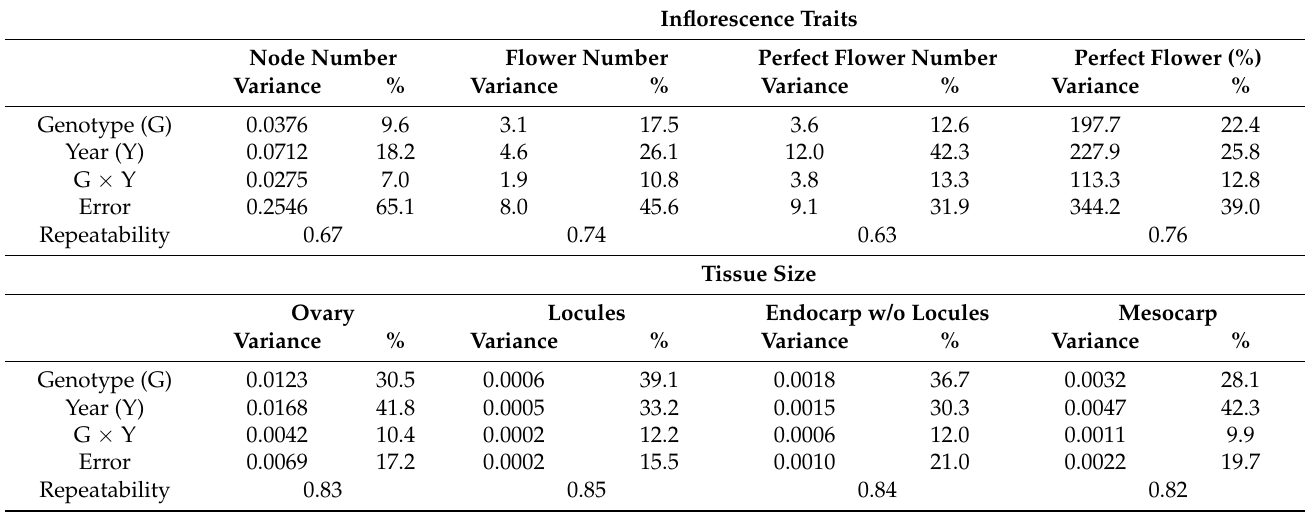
Table 2. Variance components in ANOVA for the different inflorescence and ovary parameters in the sixteen seedlings and two parents (‘Picual’ and‘Arbequina’). Significant differences at p < 0.01 were obtained for all factors (genotype, year, and genotype × year) and